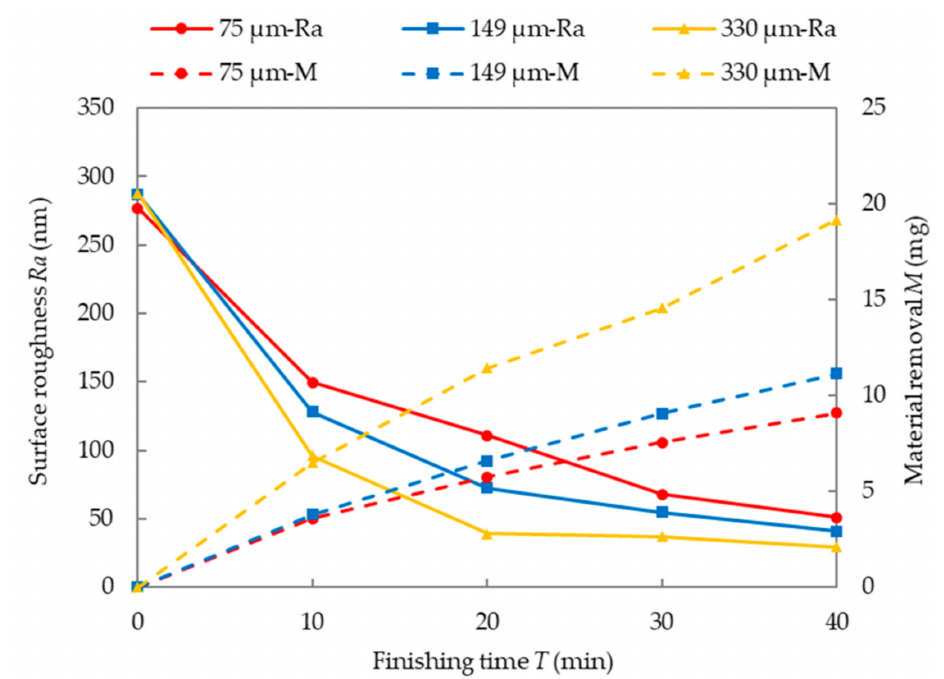
Figure 9. The e ff ect of magnetic particles size on surface roughness and material removal. (Current